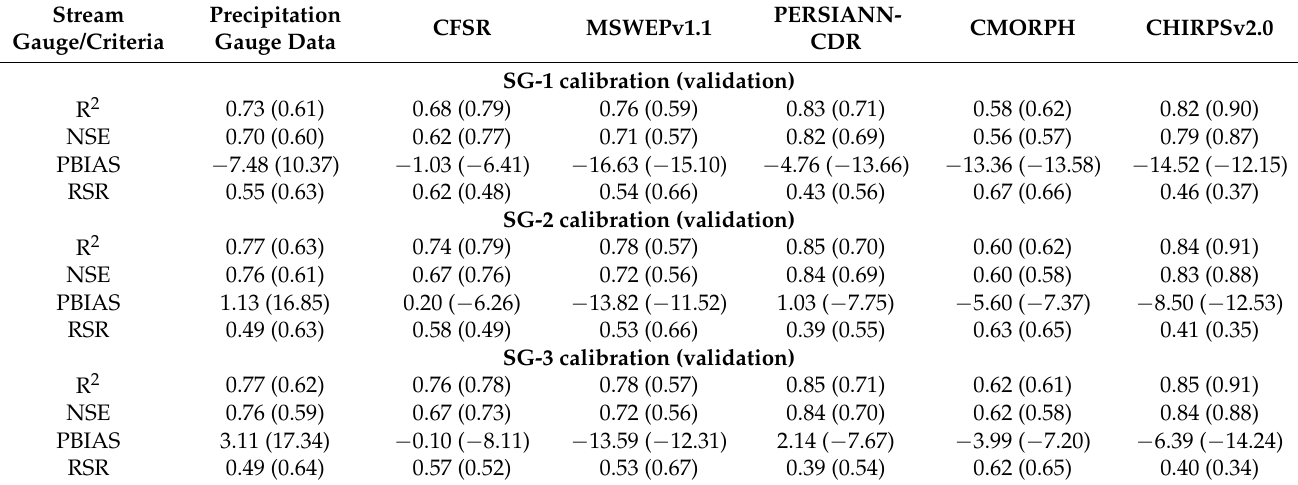
Table 11. Performance of SWAT simulations at a monthly scale based on the input of different precipitation products for calibration (2005–2007) and validation (2008–2010) for three stream gauges.